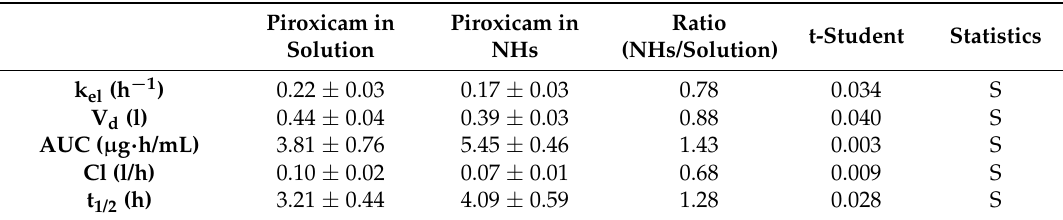
Figure 7. Plasma concentration piroxicam and piroxicam-NHs after IV administration. Table 4. Piroxicam pharmacokinetic parameter values after IV administration as a free drug or as NHs-piroxicam. S = significant statistical differences.